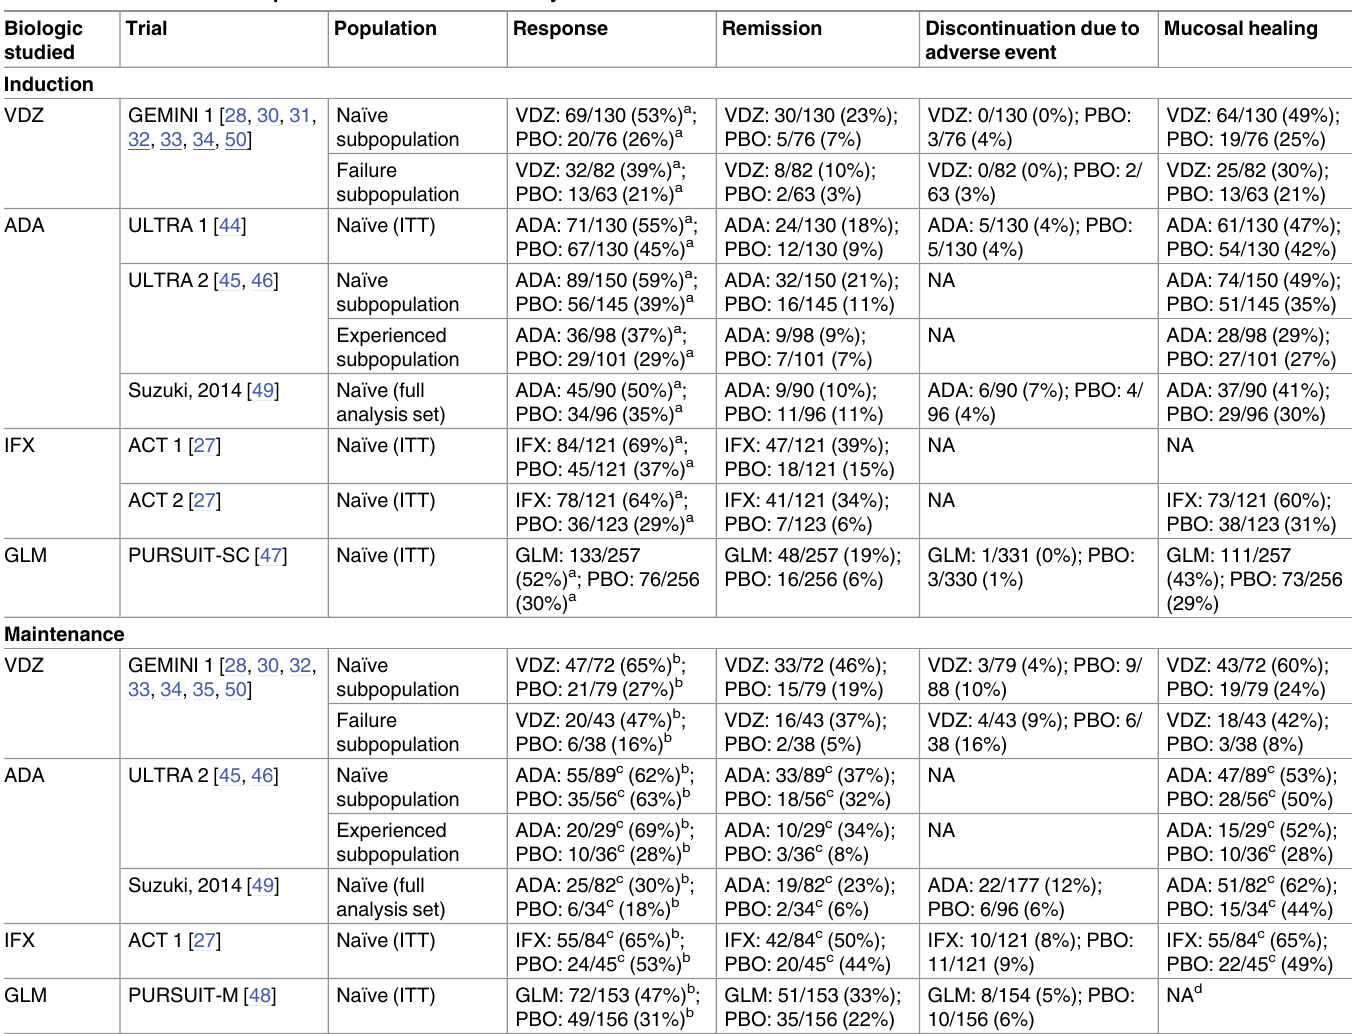
Table 2. Treatmentsand endpoints available for